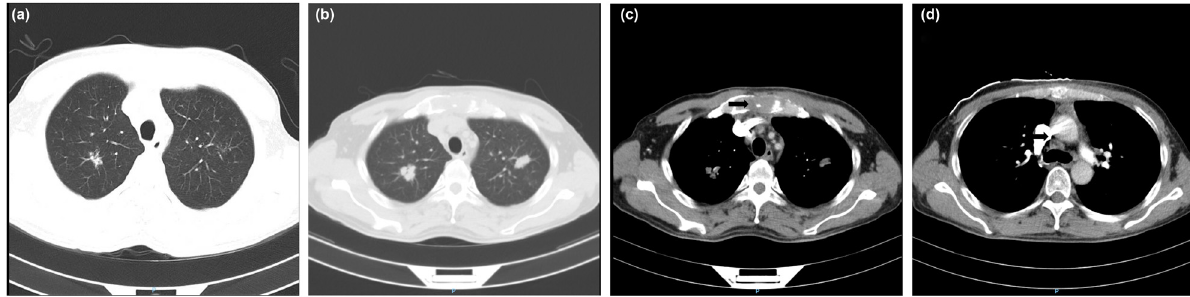
Figure 2: CT scan performed at the initial treatment of DM showing scattered in fl ammation nodules in lung apices ( a ) , enhanced CT scan performed during this admission showing bilateral apical lung nodules with lobulated and spiculated margins ( b ) , sternal osteolytic destruction ( c ) black arrow ) , and mediastinal lymphadenopathy ( d ) black arrow )